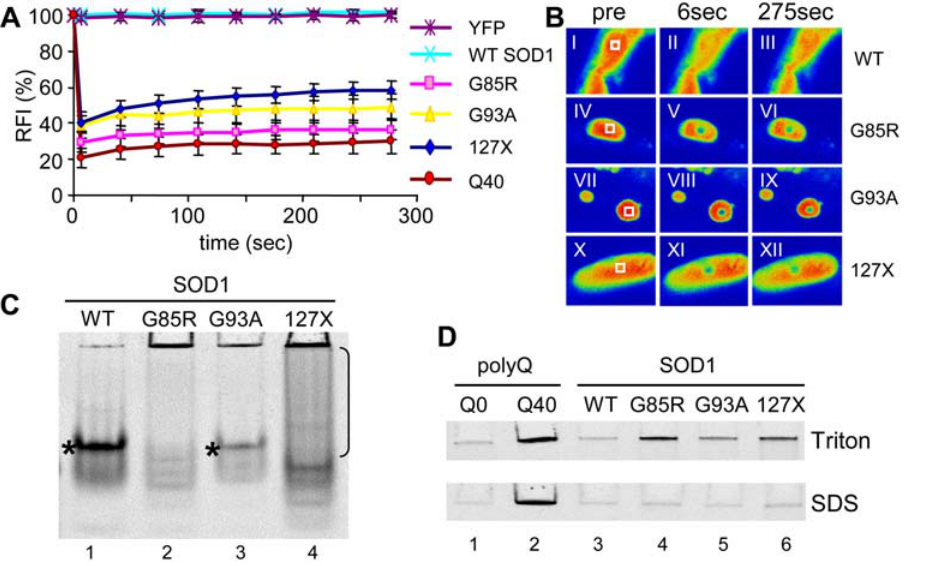
Figure 2. Mutant SOD1 proteins form biophysically variable aggregates. ( A ) FRAP analysis of fluorescent foci of SOD1. WT SOD1 protein (light blue) is indistinguishable from soluble YFP protein (purple). The fluorescence recovery of G85R and G93A (pink and yellow) is consistent with stable aggregates, but shows higher initial recovery than polyQ40 species (red). 127X protein demonstrates continued slow recovery consistent with less stable aggregates (blue). The traces are averages of 7 replicates. ( B ) Fluorescent micrographs of representative FRAP experiments. Panels I through III show a concentrated area of fluorescence in WT SOD1 muscle cell before bleaching (pre), immediately post bleaching (6 seconds) and at the end of the experiment (275 seconds). The bleached area is denoted by a white square. Panels IV through XII show FRAP experiments on G85R (IV to VI), G93A (VII to IX) and 127X (X to XII) foci, note presence of bleached area even at 275 seconds post bleach. ( C ). 7.5% native PAGE of extracts from indicated mutant strains. Mutant proteins contain high molecular weight material that did not enter the gel (lanes 2 to 4). WT SOD1 (lane 1) and G93A (lane 3) contain a major soluble band (star), which corresponds to enzymatically active SOD1 protein (Figure S2, arrows). G85R (lane 2) and 127X (lane 4) exhibit presence of multiple soluble species, none of which contain enzymatic activity (Figure 2S); 127X also presents unresolved smear below the aggregated material (bracket), suggesting a continual dissociation of aggregates during electrophoresis. ( D ) Native extracts were treated with 0.5% Triton X-100 or 5% SDS for 15 minutes at room temperature and resolved by 5% native PAGE. SOD1 mutants contained aggregates that dissociated upon SDS treatment (lower panel, lines 4 to 6). Polyglutamine aggregates were used for comparison (line 2). Gels in panels ( C ) and ( D ) are representative of at least three